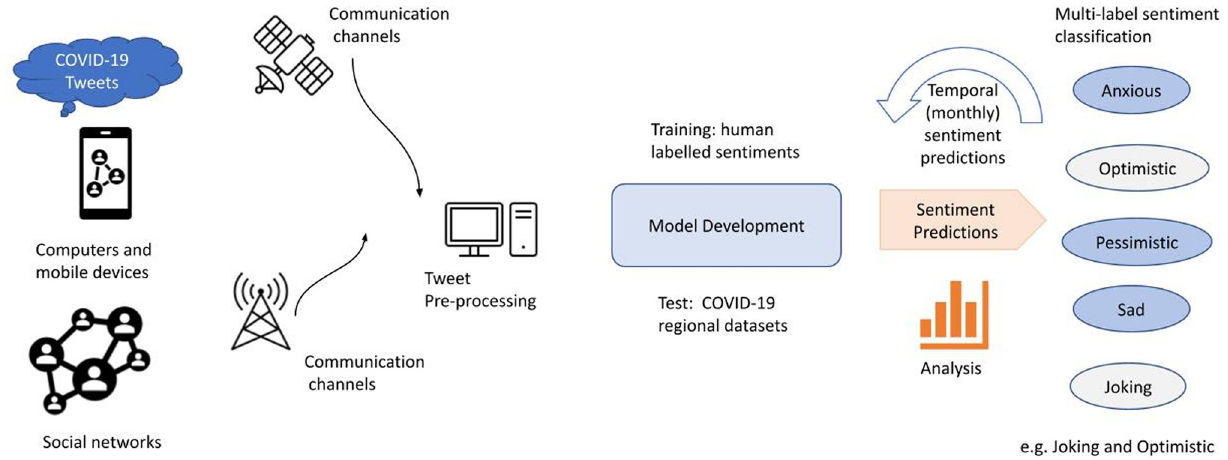
Fig 1. Framework: Twitter-based sentiment analysis for COVID-19 with model development via LSTM, BD-LSTM and BERT. After training, the best model is chosen for prediction of COVID-19 tweets from India. Note that the framework features multi-label classification which has the ability to provide more than two outcomes at once; i.e. a tweet can be optimistic and joking at the same time.